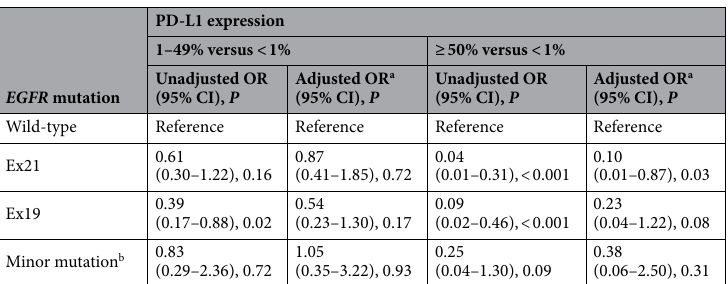
Table 5. The multinomial logistic regression analysis to investigate the association between the expression of PD-L1 and EGFR mutations. PD-L1 programmed death-ligand 1, EGFR epidermal growth factor receptor gene, OR odds ratio, CI confidence interval, Ex21 exon 21 L858R mutation, Ex19 exon19 deletion mutation. a Adjusted by age, sex, smoking status, pathological stage and histological type. b Defined as all mutations except Ex21 and